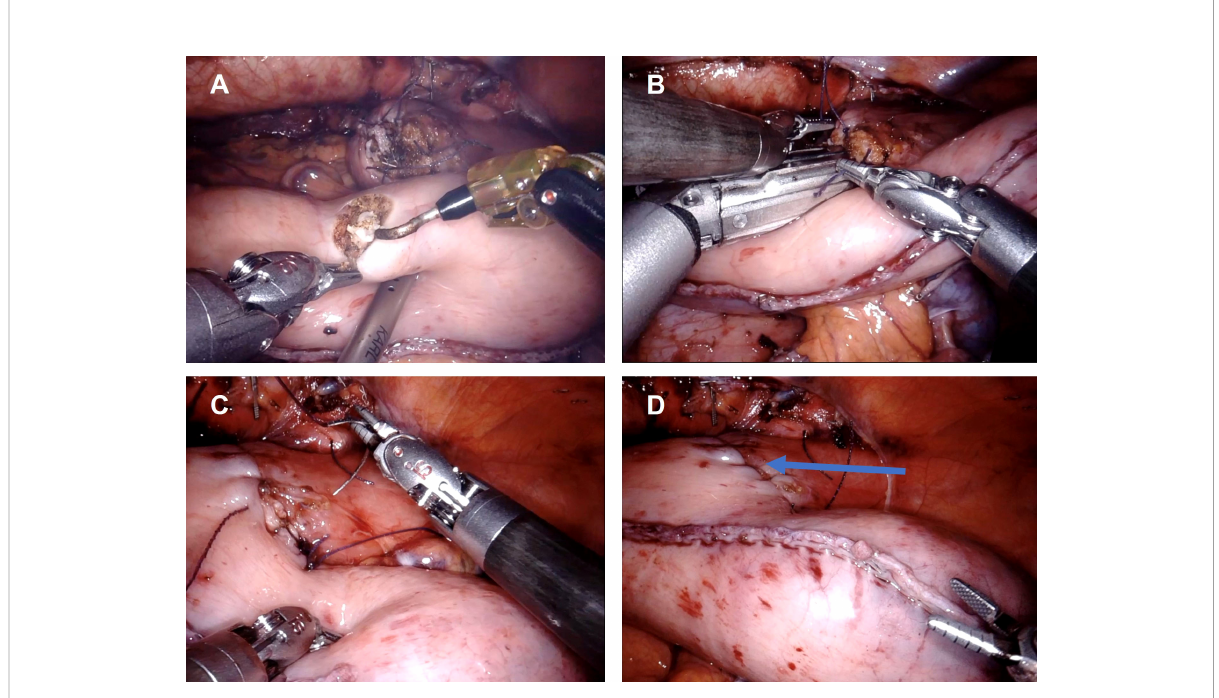
FIGURE 1 Robot-assisted linear stapled side-to-side esophagogastrostomy. (A) Opening of the gastric conduit. (B) Intrathoracic stapling of the anastomosis with the linear stapler. (C) Closure of the incision hole in esophagus and gastric conduit. (D) Completed side-to-side esophagogastrostomy (blue arrow indicates location of the esophagogastric